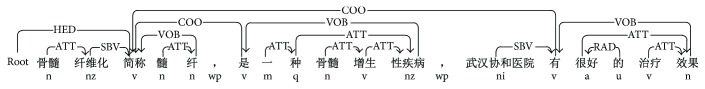
An example sentence with dependency parsing and POS tagging.